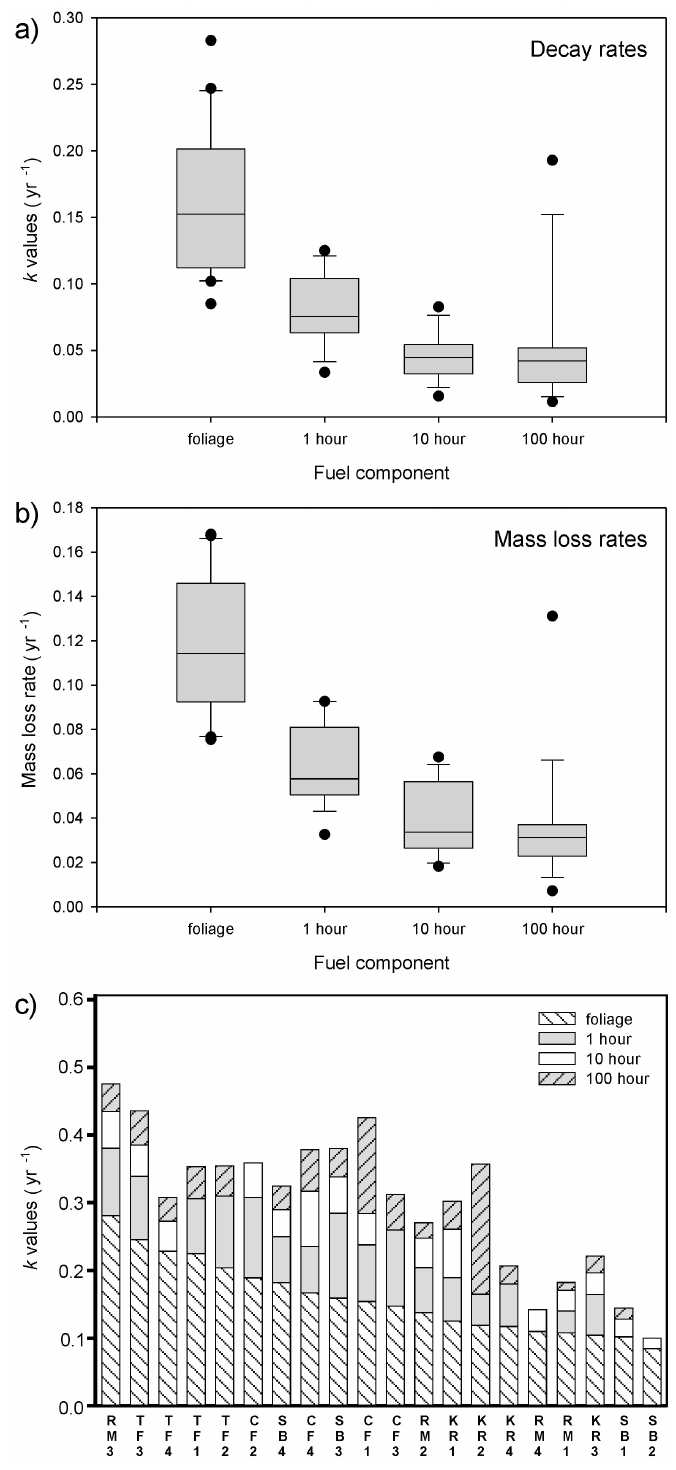
Figure 7. Rates of decomposition expressed as ( a ) k values for each fuel component, ( b ) mass loss rates for each fuel component; and ( c ) k values for each site by fuel component. Site descriptions ID numbers on the X axis can be found in Keane [31]. Sites are arranged in order of elevation from highest to lowest. Some sites did not have decomposition estimates [31].